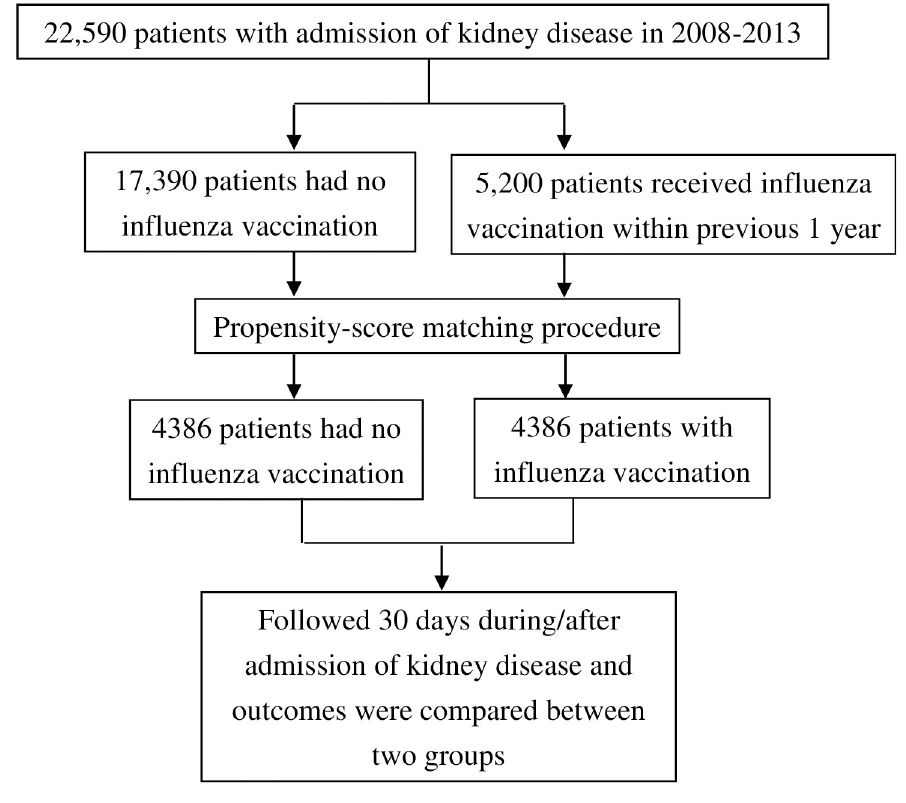
Fig 1. Selection process of study